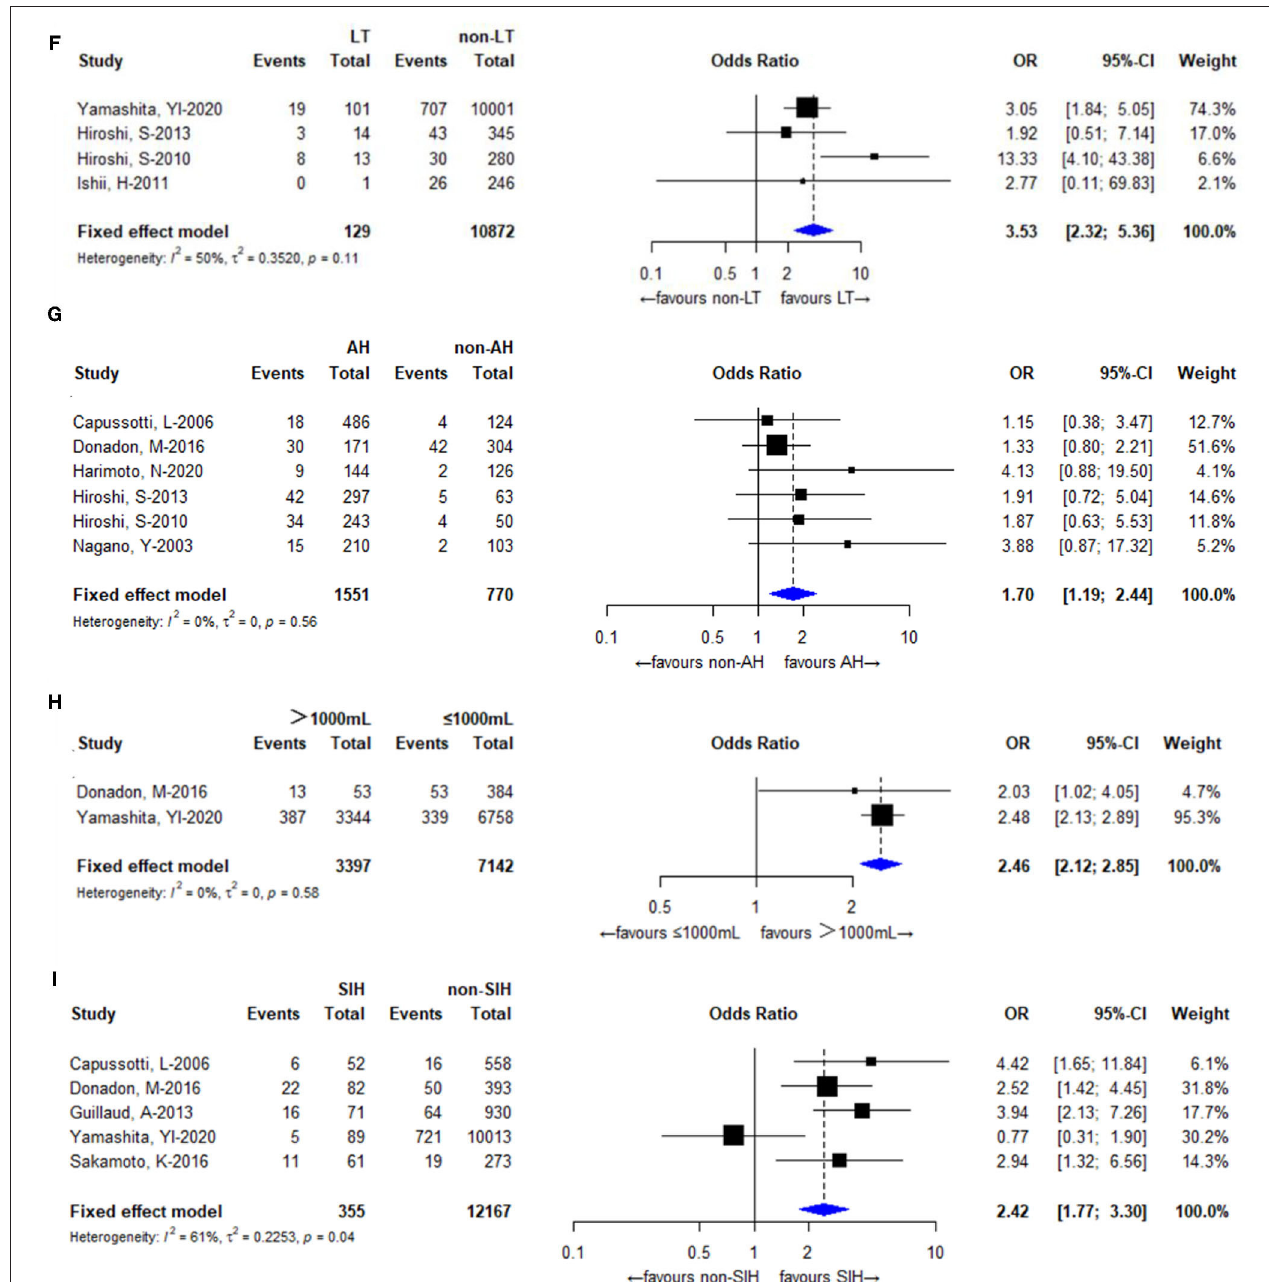
FIGURE 3 | Forest plots for the meta-analyses. (A) Sex; (B) Diabetes; (C) Extended hemihepatectomy (EH); (D) Central hepatectomy (CH); (E) Liver cirrhosis (LC); (F) Left trisectionectomy (LT); (G) Anatomical hepatectomy (AH); (H) Bleeding; (I) Segment I hepatectomy (SIH).